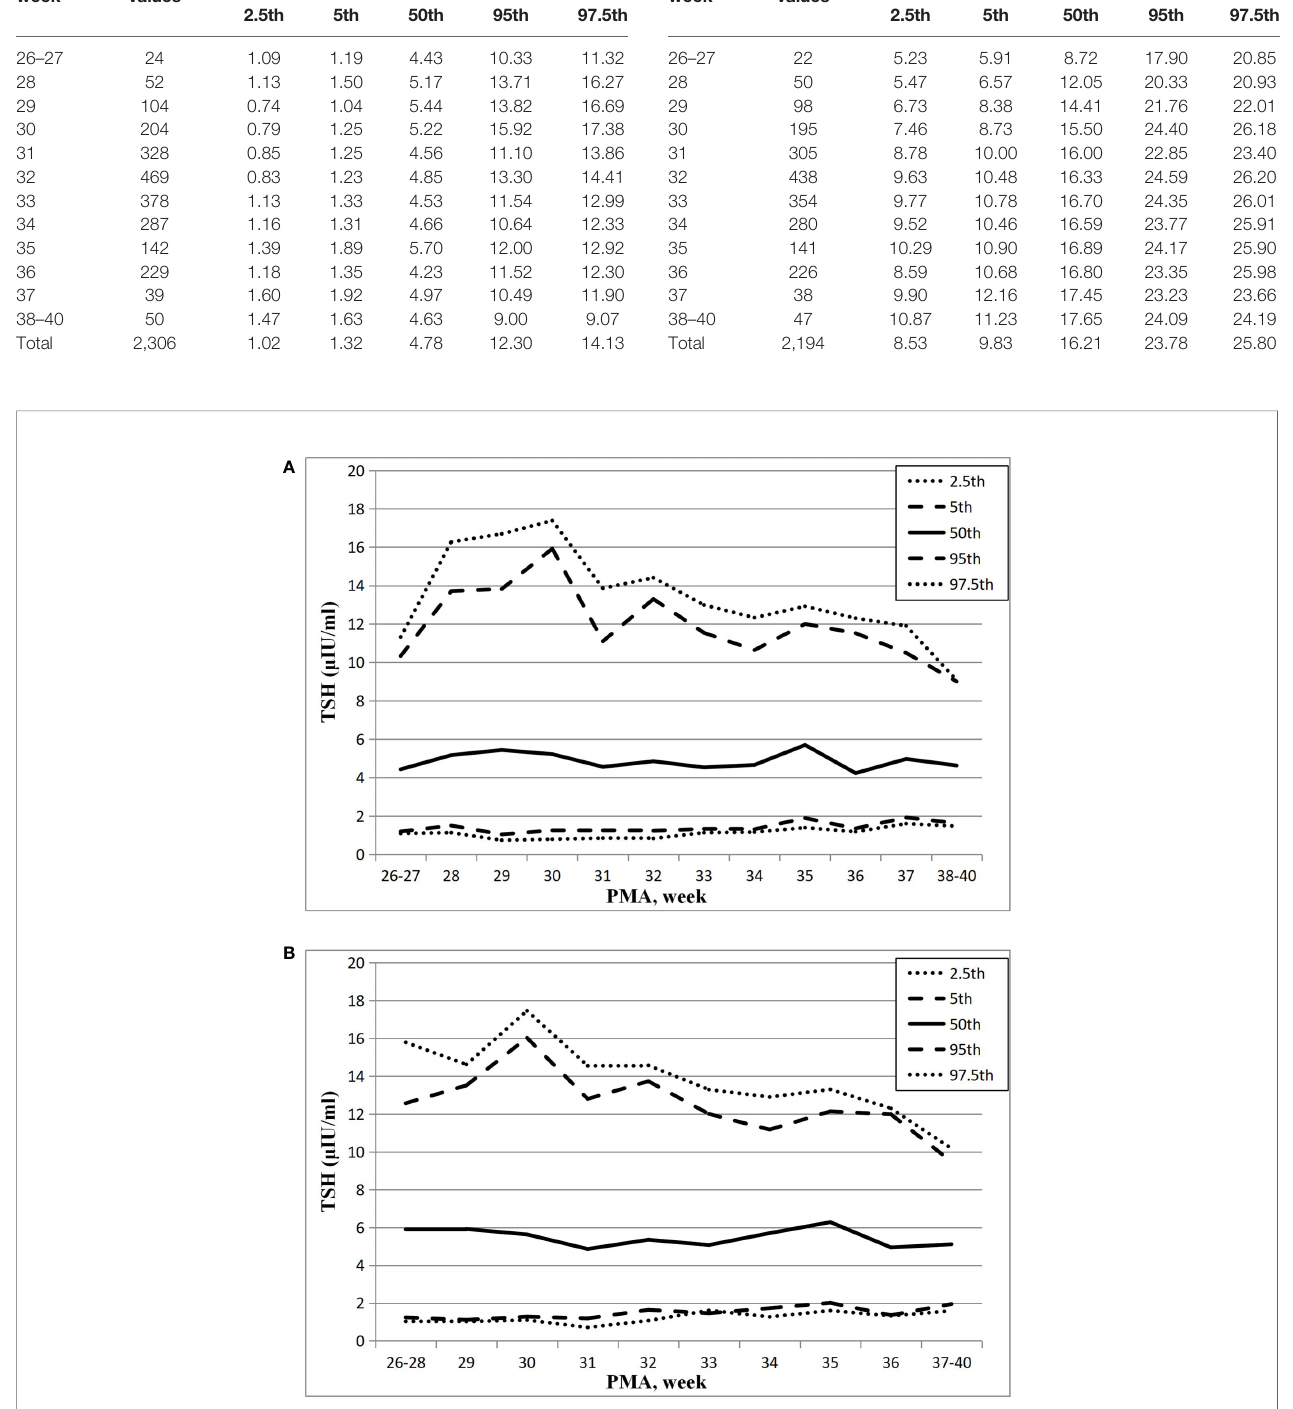
FIGURE 2 | Reference chart of TSH based on PMA in preterm infants born with GA < 32 weeks. (A, B) represent the percentile charts of TSH based on PMA in total 27 NICUs and 17 NICUs using the same measurement assay, respectively.